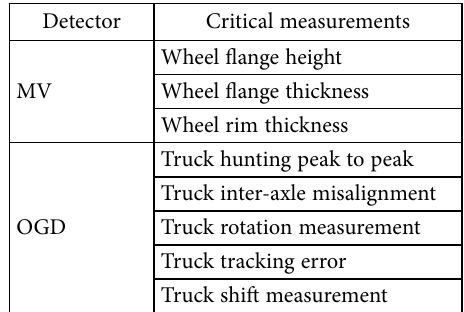
Table 1. Critical measurements of